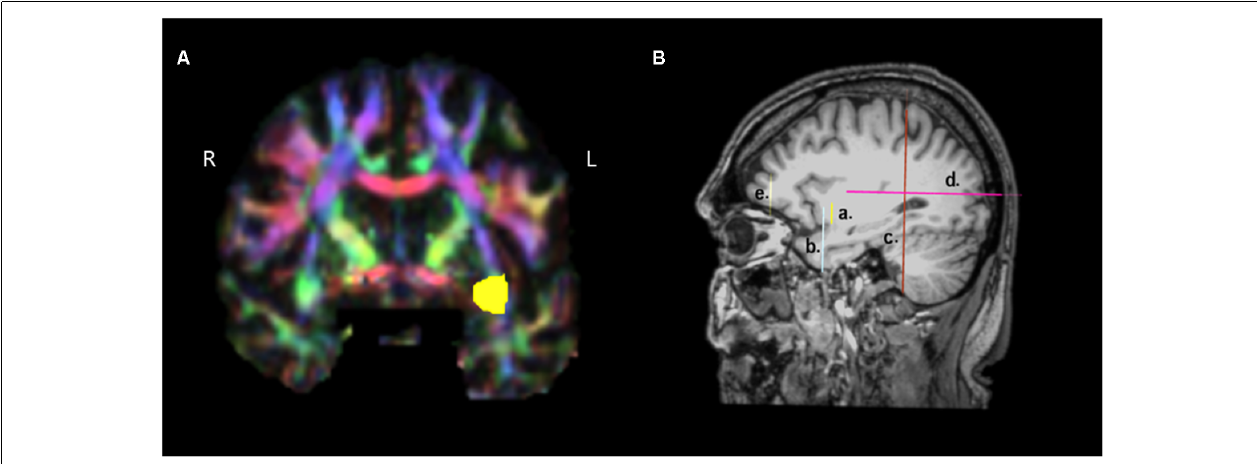
FIGURE 1 | Presentation of the regions of interest (ROIs) used for the reconstruction of the temporo-frontal extreme capsule fasciculus (TFexcF). (A) Coronal section at the most anterior point where the temporal lobe joins with the frontal lobe. The green region of the relevant white matter in the right (R) hemisphere is marked with yellow color in the left (L) hemisphere. (B) a. Location of the inclusion ROI in the anteriormost joining of temporal lobe with the frontal lobe (see A ); b. location of the exclusion ROI for the temporal pole and anterior ventromedial temporal lobe; c. location of the exclusion ROI for the occipital region; d. location of the exclusion ROI for the posterior temporoparietal region; e. location of the exclusion ROI for the most anterior region of the frontal